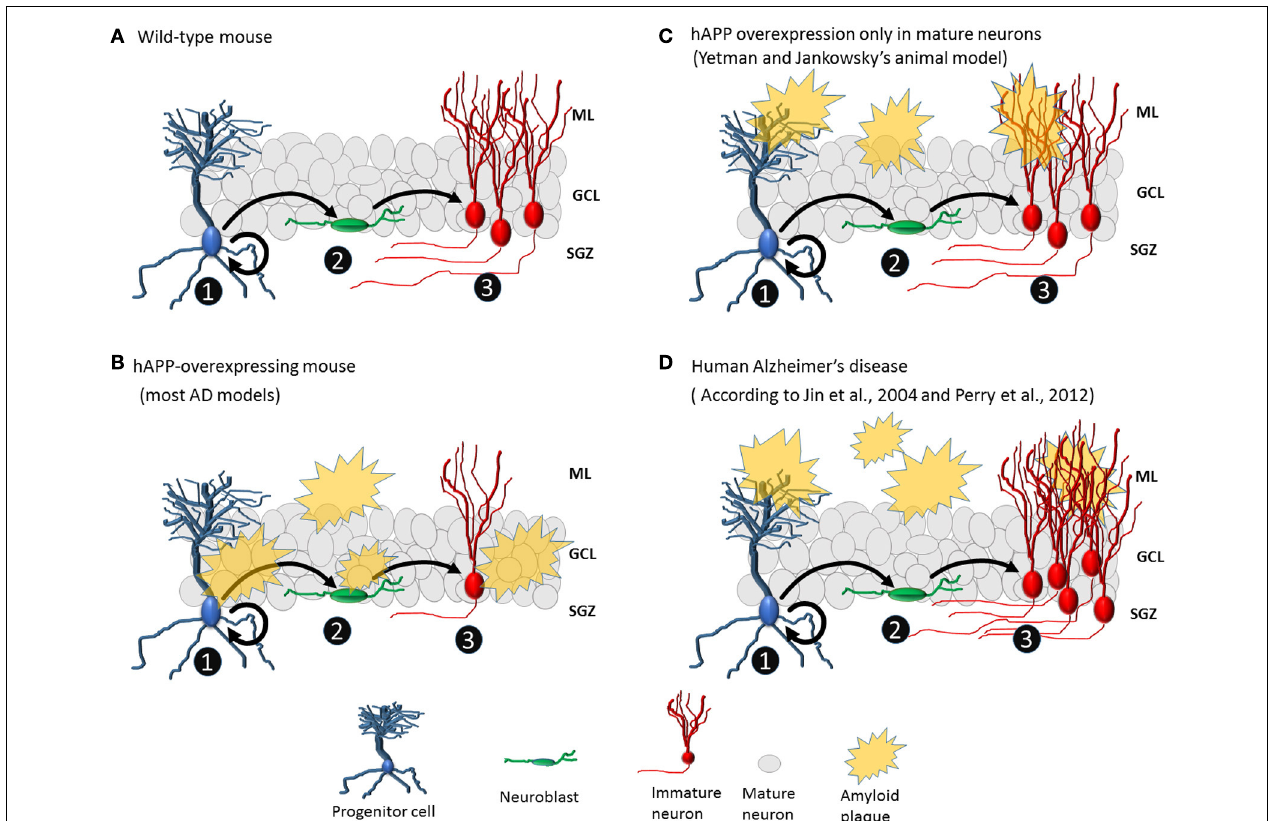
FIGURE 1 | Amyloid plaques affect neurogenesis differently in animal AD models and human AD. (A) No plaques are present in wild-type mice. Progenitor cells divide asymmetrically, leading to the formation of new progenitor cells (1) and neuroblasts (2). Neuroblasts become immature neurons (3) that migrate to their final positions and extend dendrites and axons. (B) Common animal model of AD with hAPP overexpression and plaque formation in the granule cell layer and proliferative area of the dentate gyrus, which may directly affect the cell